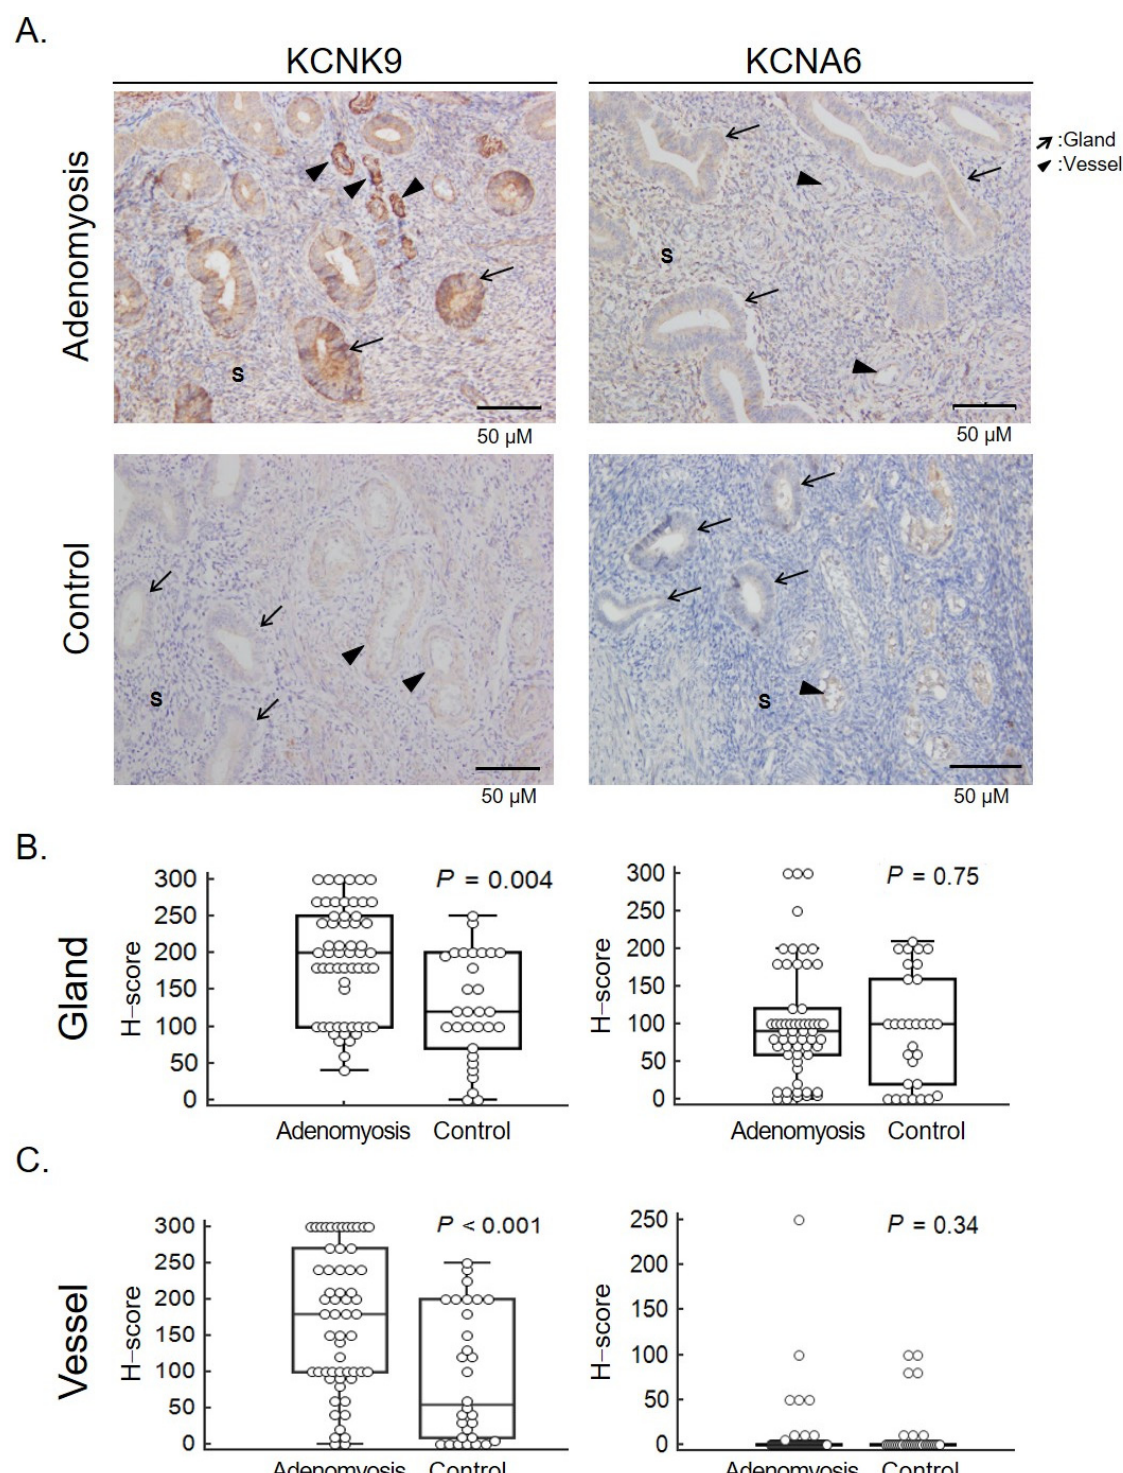
Figure 3. KCNK9 and KCNA6 expression in the eutopic endometrium of patients with adenomyosis and controls. ( A ) Representative immunohistochemical (IHC) staining of KCNK9 and KCNA6 pro- teins. Endometrial glands and vessels are indicated by arrows and triangles, respectively. S, stroma. Comparison of KCNK9 and KCNA6 expression in endometrial glands ( B ) and vessels ( C ). The expres- sion was scored as follows: intensity x area of positively stained cells (%). Significant high expression of KCNK9 in the endometrial glands ( p = 0.004) and endometrial vessels ( p < 0.001) in adenomyosis.